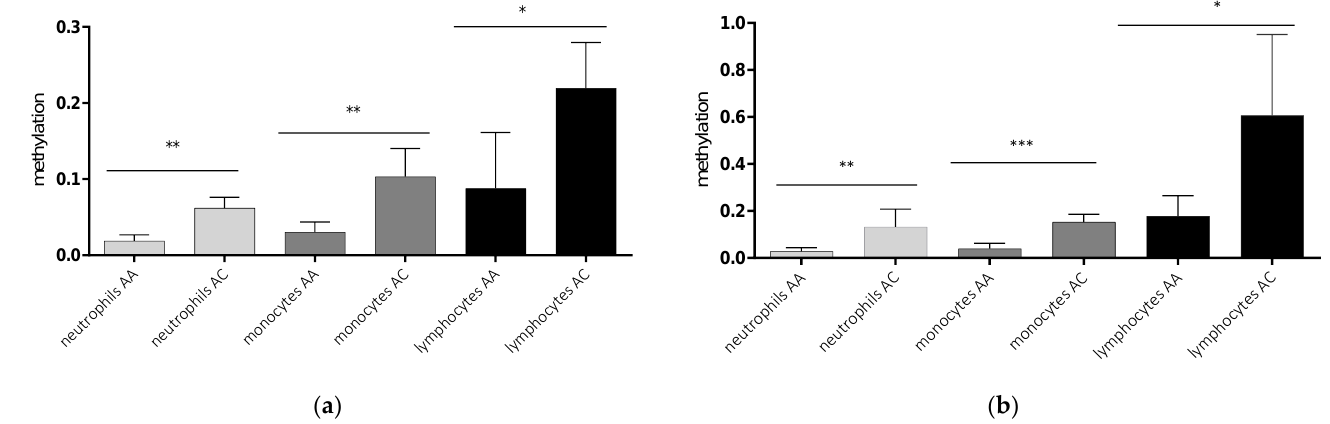
Figure 2. Genotype-dependent methylation in the promoter region nt-145 to nt-49 in different blood cells of healthy controls ( a ) and septic patients ( b ). Neutrophils, monocytes, and lymphocytes were isolated using magnetic separation, DNA extraction, bisulfite conversion and methylation-specific PCR for the promoter region from nt-49 to nt-145. Cells from C-allele carriers ( n = 4) show higher methylation than cells from A-allele carriers ( n = 3) in healthy controls ( a ) and cells from septic patients, where C-allele carriers ( n = 3) showed higher methylation than A-allele carriers ( n = 7) (* p ≤ 0.05; ** p ≤ 0.01 ; *** p ≤ 0.001 )